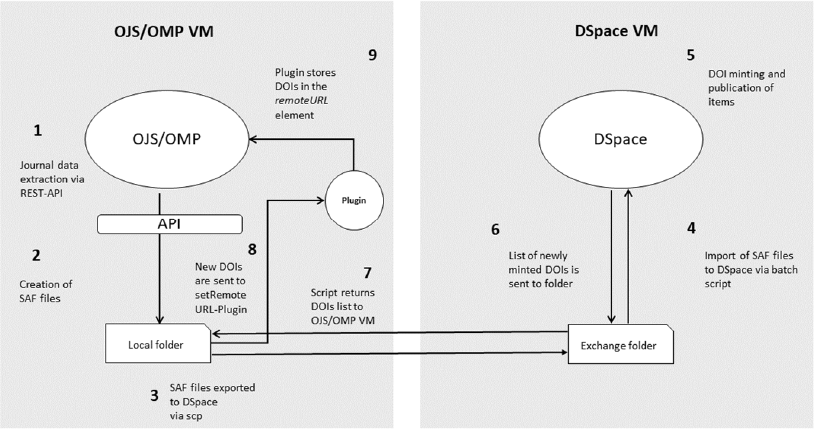
Figure 4. Schematic representation of the connection of OJS, OMP and DSpace to OS-APS.